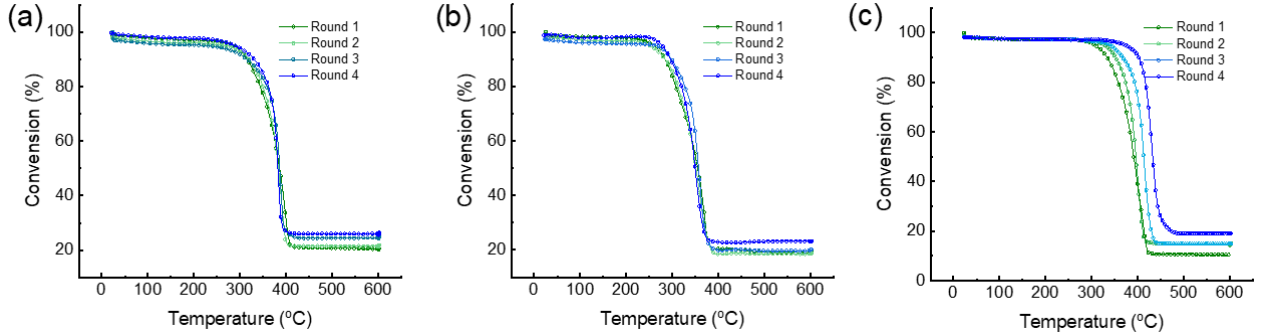
Figure 10. Weight loss curve of LDPE pyrolysis over ( a ) H-Z5-PK3-1, ( b ) H-Z5-PK3, and ( c ) C-Z5 in the four consecutive pyrolysis–regeneration cycles.